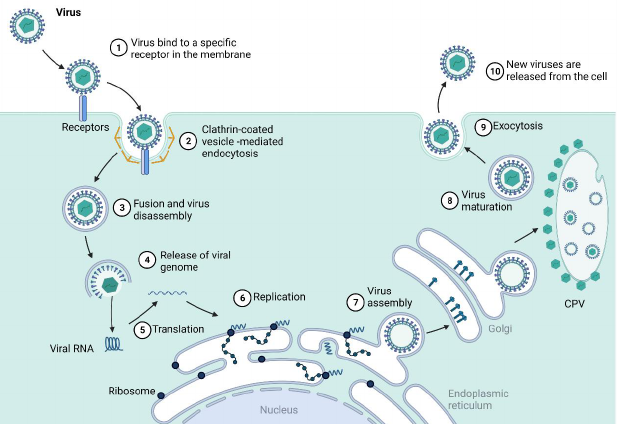
Figure 2. Alphavirus replication. After binding to specific receptors in cells (1), membrane invagina- tion occurs, forming clathrin-coated vesicles with the viral particle inside (2) that are later taken by endosomes, whose low pH environment promotes envelope proteins E1/E2 fusion to the endosomal membrane, and the nucleocapsid is released into the cytoplasm with further viral RNA liberation (3, 4). Translation of the non-structural proteins is initiated, and replication occurs associated with ER membranes forming the cytopathic vacuoles (CPVs) (5, 6). After the replication process and syn- thesis of structural proteins, viral assembly and maturation (7, 8) take place, and budding from the cell membrane occurs through interactions of the nucleocapsid proteins with membrane glycopro- teins, and virion are released to infect new cells (9, 10). Based on: Garoff, Sjôberg and Cheng (2004) [32] and created with BioRender.com (Accessed on 14 September 2022). After this process, the P23 portion, which is present only for a few seconds, is pro- cessed, yielding the fully cleaved replicase complex that promotes RNA synthesis with the individual nonstructural proteins nsP1, nsP2, nsP3 and nsP4 [19,33]. After forming the RNA replicase complex by the nonstructural proteins, the positive-stranded RNA is trans- lated into a polyprotein that is cleaved into three structural proteins: C — the capsid pro- tein, PE2, and E1. PE2 is then processed into E2 and E3, responsible for envelope assembly together with the E1 glycoprotein. The viral envelope comprises a lipid bilayer derived from the host cell membrane and the main E1 and E2 glycoproteins anchored as spikes in an orderly arrangement [34,35]. The structural proteins, essential for virion assembly, are translated from subgenomic RNA, as CHIKV shuts down cell mRNA translation to pro- duce its mRNAs. Viral particle assemblage occurs on the membrane of infected cells, and nsP1 works as a defence mechanism against host antiviral effects at this stage [29]. As alphaviruses disseminate mostly through the lymphatics and microvasculature, the blood is loaded with virion particles and infected monocytes that target other organs. The liver and spleen are sites for further viral replication and dissemination (Figure 3). Subse- quently, the viral particles can reach bones, muscles, and articular tissues, which charac- terizes the acute phase of the disease, where inflammatory infiltrate rich in monocytes, macrophages, natural killer cells, CD4+ and CD8+ lymphocytes are prevalent and affect joints and muscles, inducing the characteristic arthralgia and arthritis symptoms [36 – 38].